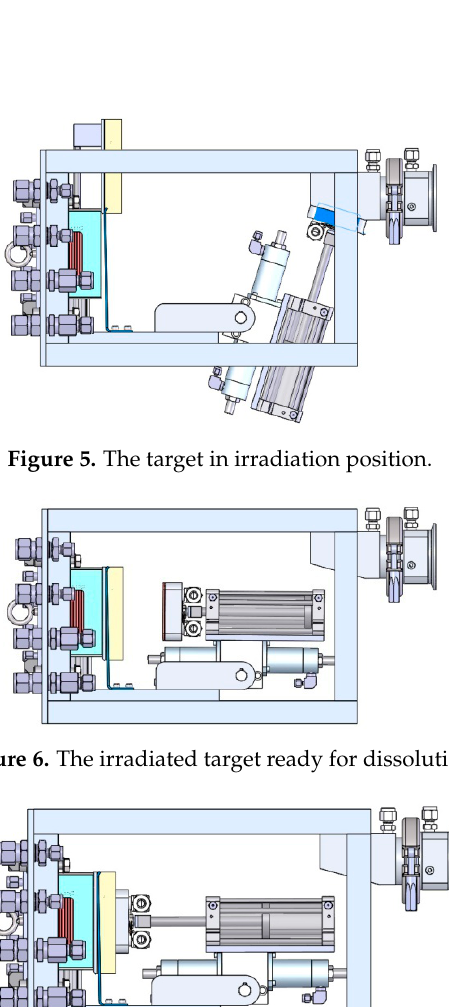
Figure 4. Grabbing the target from the cassette.